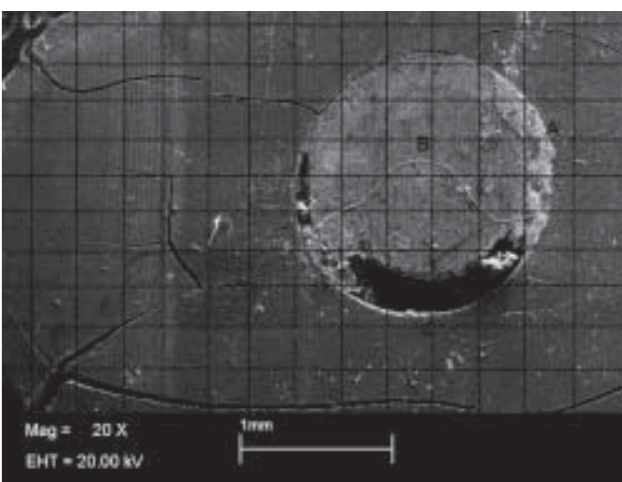
Figure 3. Specimen of Group II. Area occupied by root canal sealer (A), gutta- percha (B) and occasional empty space (C), with integration grid inserted (×20 magnification).